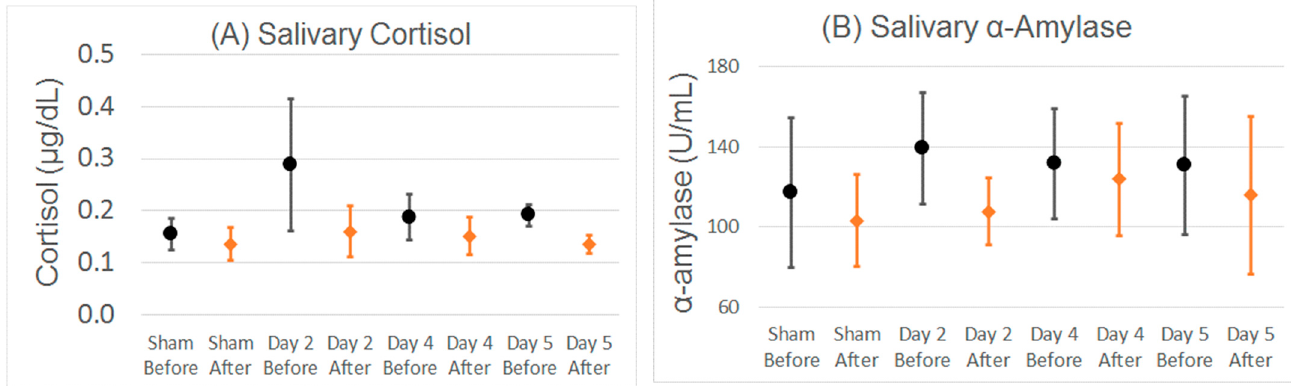
Figure 5. Salivary ( A ) cortisol and ( B ) α -amylase changes before and after TEN/sham and anxiety-provoking tasks. Mean and standard error bars are shown. There were no statistically significant differences between the sham and TEN days, or before as compared to after TEN/sham and anxiety-provoking tasks for the whole